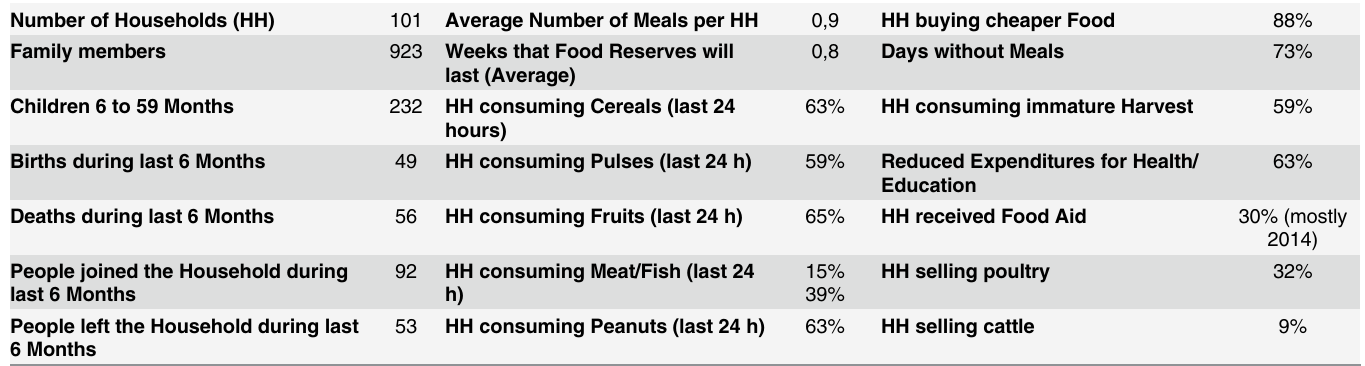
Table 1. Key results of the assessment (HH = Household).